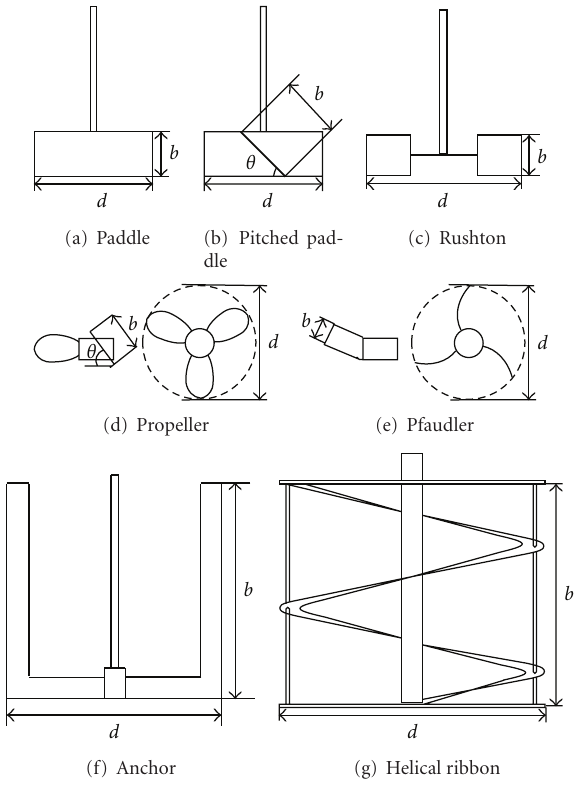
Figure 2: Geometry of mixing impellers.